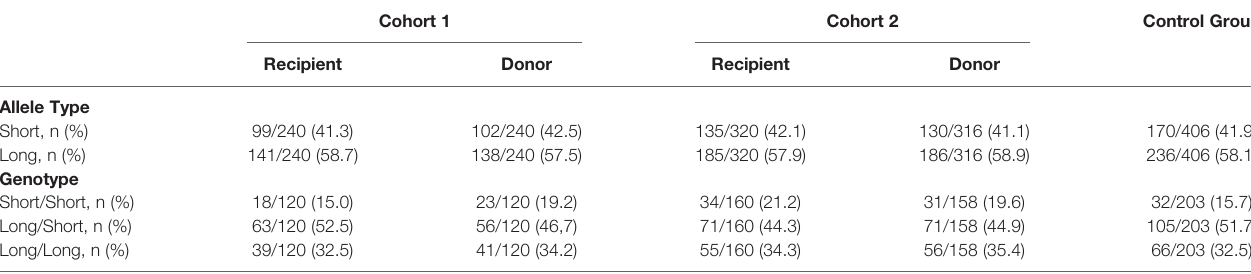
TABLE 3 | Allele and genotype frequencies in the two cohorts and the control group.